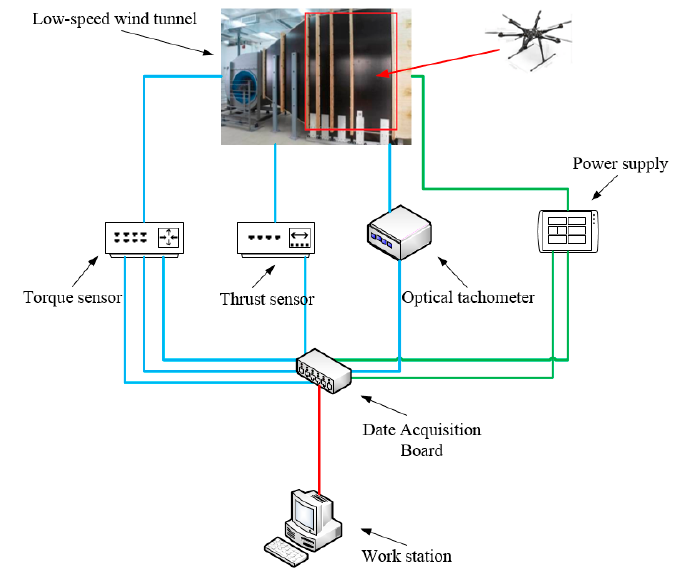
Figure 2. Experimental setup.